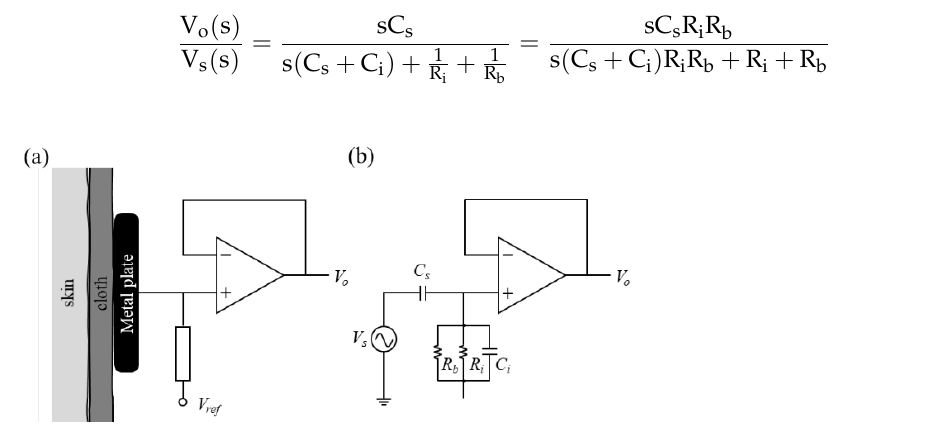
Figure 2. ( a ) Basic structure and ( b ) equivalent electrical circuit of noncontact electrode.